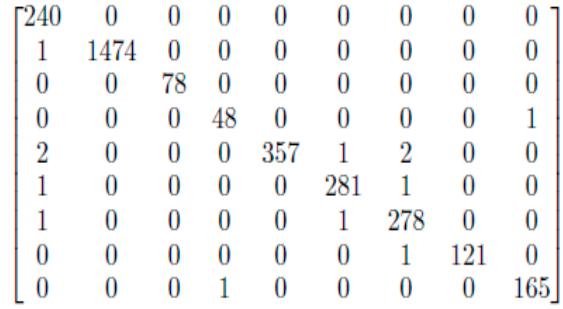
Figure 4. Encoded DNA sample from Class 9.